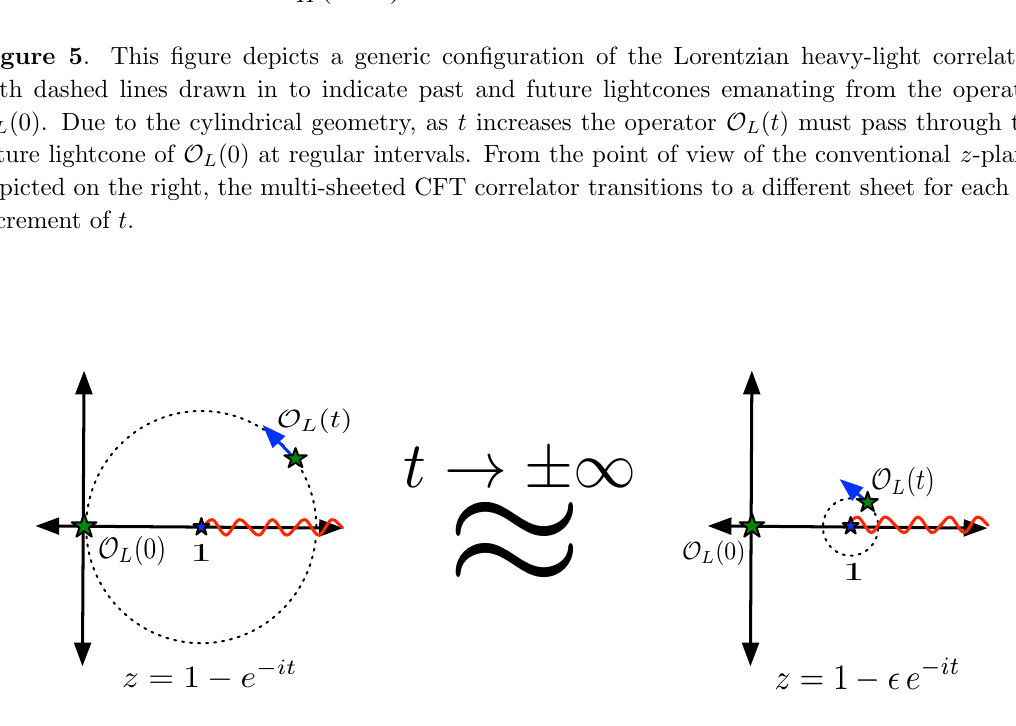
1 z small. The semiclassical Virasoro blocks depend on j (cid:0) j times around z = 1. This means the late time behavior can be determined 2 (cid:25) z 1 while keeping the phase of this quantity arbitrary. See (cid:12)gure 5 for j (cid:0) j